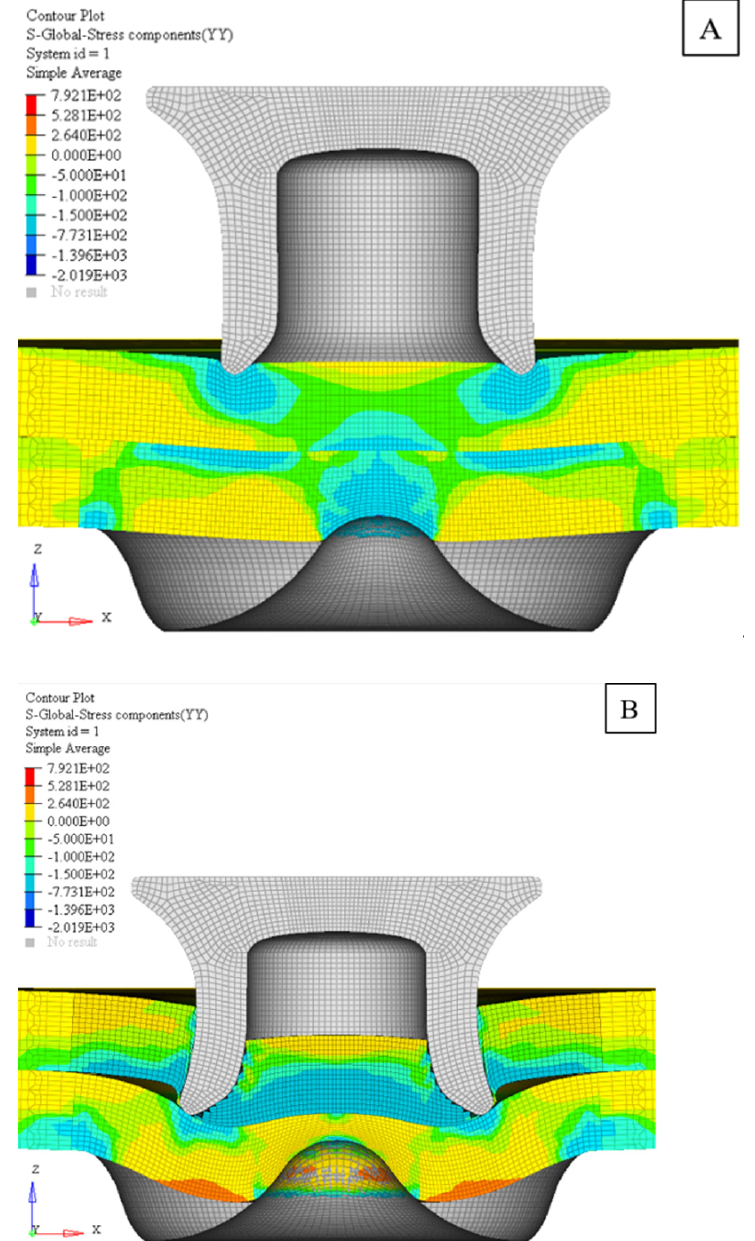
Figure 8. The punch force-displacement curve and stress distribution at the stages ( A , B ) during the SPR process.